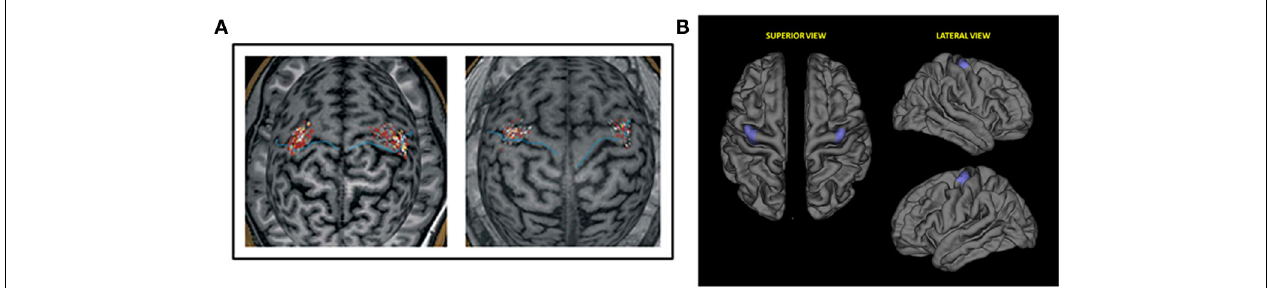
FIGURE 1 | (A) Representative first dorsal interosseus (FDI) motor evoked potentials (MEPs) data for study sample. Single pulses applied to the FDI hotspot on MR images of the subjects’ brains. Left: young subject (aged